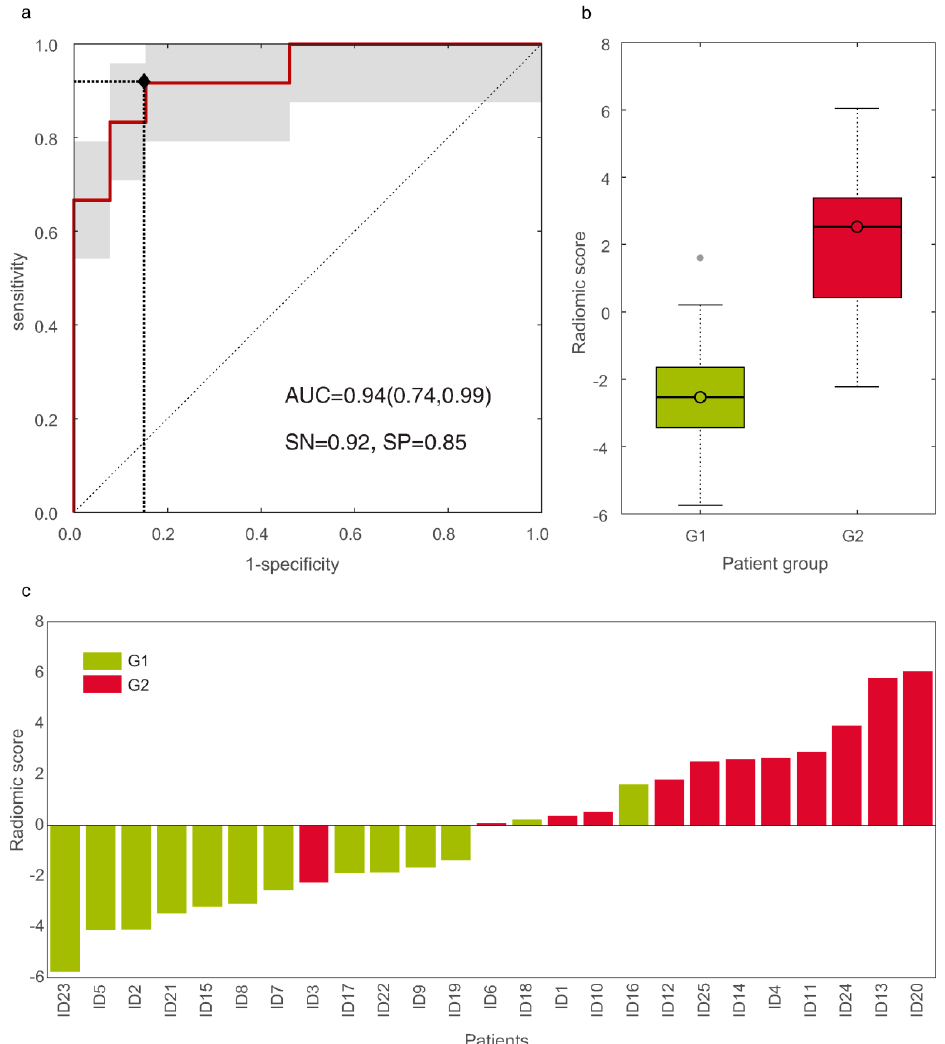
Figure 4. The ROC curve of the discriminative radiomic model ( a ). Boxplots of radiomic scores (RS) of grade 1 (G1) and grade 2 (G2) groups, with median values of − 2.53 and 2.53, respectively ( b ). Waterfall plot of the RS of G1 (green bars) and G2 (red bars) pancreatic neuroendocrine neoplasia (panNET) patients ( c ).